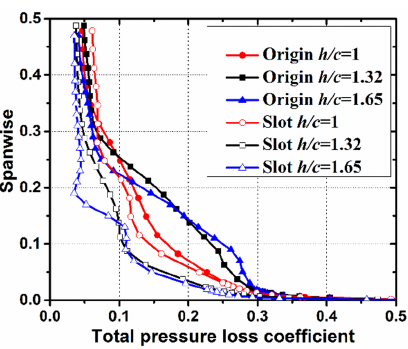
Figure 9. Influence of aspect ratio on the spanwise profile of total pressure loss coefficient at the i = 3° incidence angle.